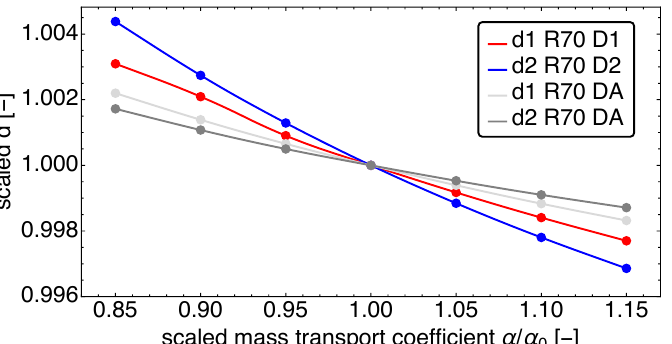
d 1 and 2 are shown as functions of the rescaled mass